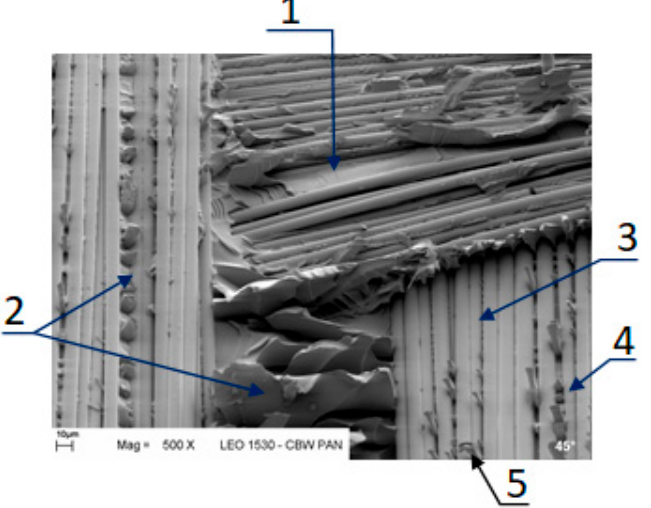
Figure 19. Local fracture modes and associated fracture mechanisms: (1) flat resin fracture surface between fibers indicate local Mode I loading, (2) resin cups indicate Mode II loading, (3) region of the backward bent strand-bear fibers indicate Mode I loading, (4) region of the strand parallel to the left-hand strand-caps indicated local Mode II loading, (5) fractured fiber.